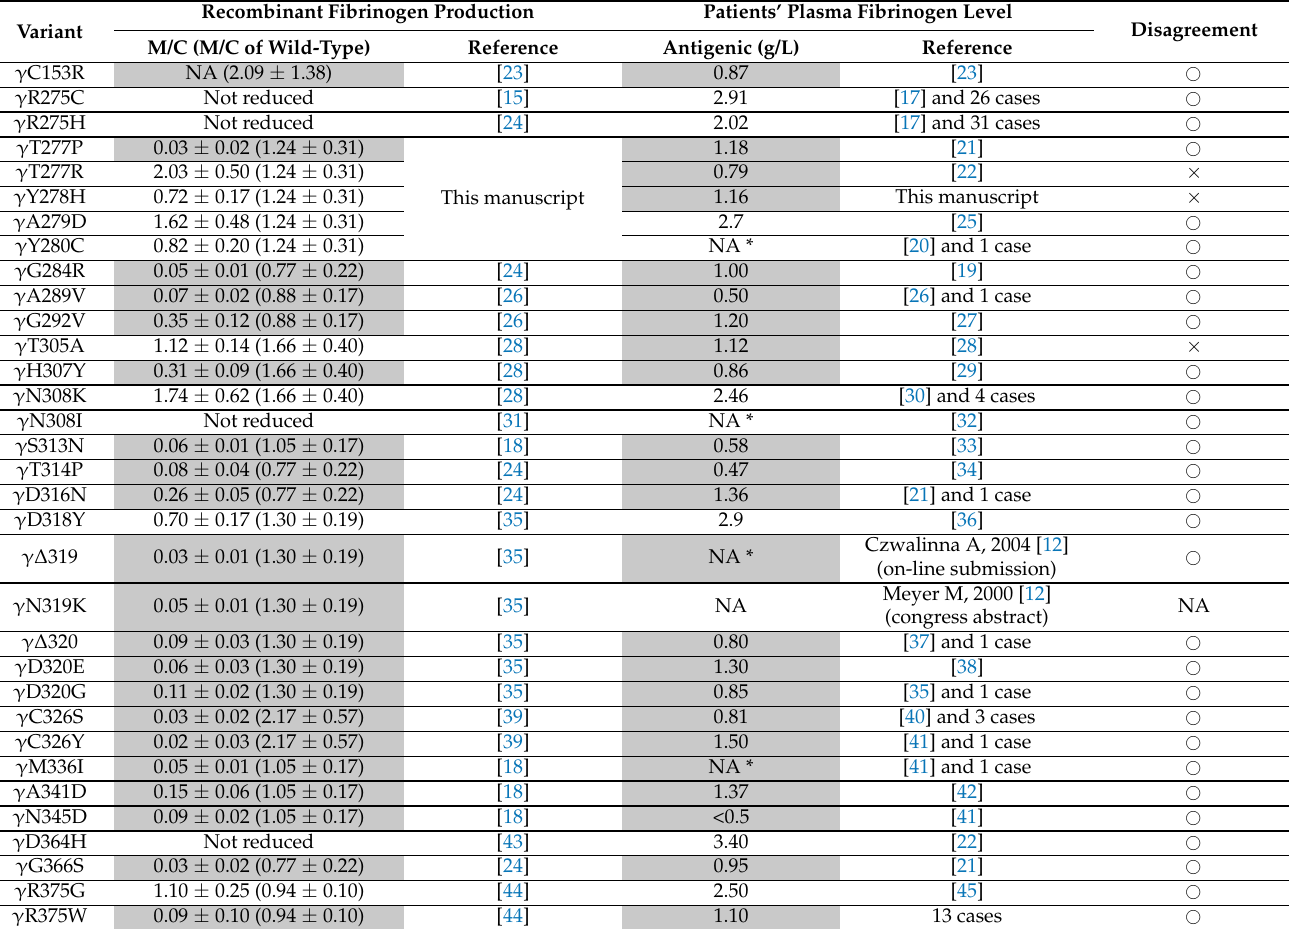
Table 1. Recombinant fibrinogen production and patients’ plasma fibrinogen level. We found the production of recombinant fibrinogens from Chinese hamster ovary cells was reduced when the ratio in culture media to cell lysate (M/C ratio) was <0.5 (grey), and the patients’ plasma fibrinogen levels were reduced when their antigenic fibrinogen level was <1.5 g/L (grey). The agreement or disagreement between recombinant fibrinogen production and plasma fibrinogen level is indicated